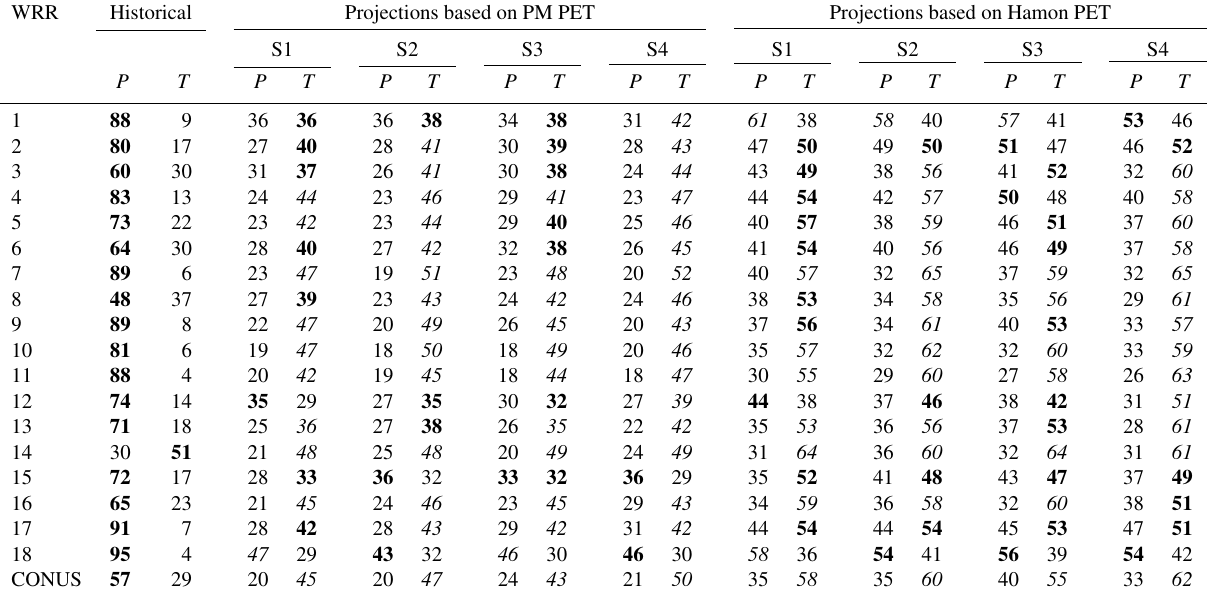
Table 2. Comparison of multi-model averaged contributions (%) of precipitation ( P ) and temperature ( T ) to changes in runoff in the 18 water resource regions (WRRs) and entire CONUS in the historical period (1961–2010) and future scenarios S1 (RCP4.5/2030s), S2 (RCP4.5/2080s), S3 (RCP8.5/2030s), and S4 (RCP8.5/2080s). A larger contributor identified by multi-model ensemble means is in bold, and a significantly larger contributor identified by Wilcoxon signed-rank test (at 5% significance) is in italic.